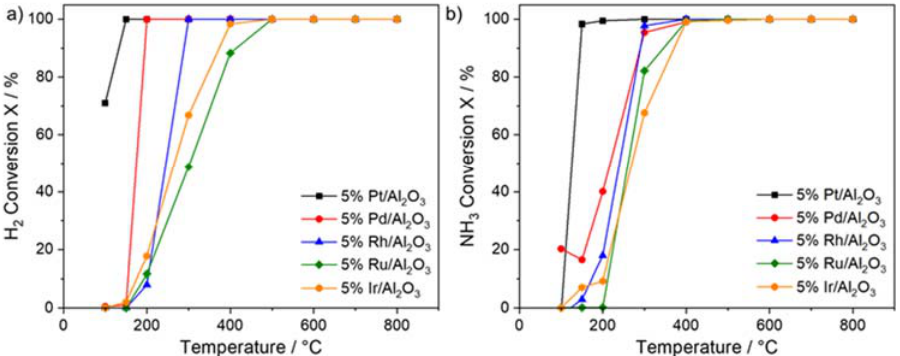
Figure 2. ( a ) Hydrogen and ( b ) ammonia conversion vs. reaction temperature for different noble metal catalysts, WHSV = 600 L/g h.